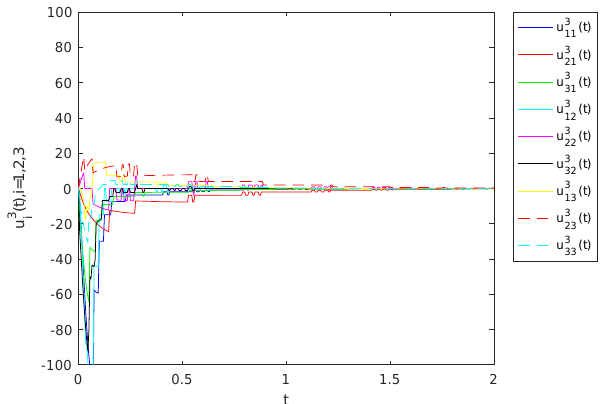
( 3 ) ( t ) in the third layer. ı